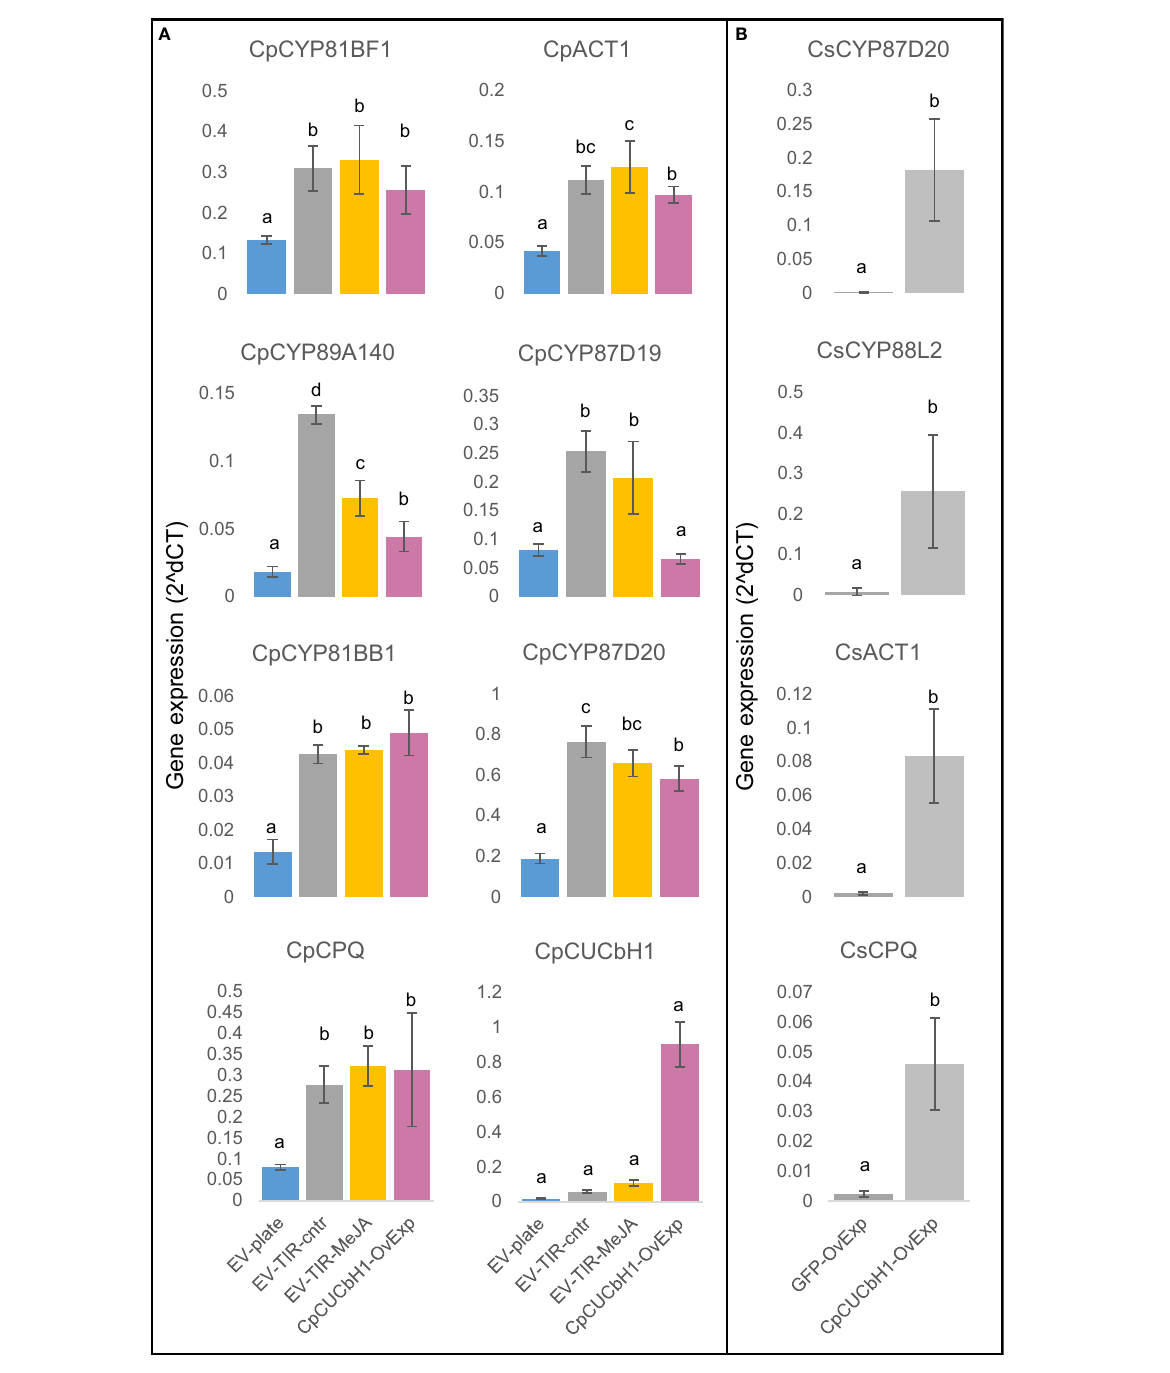
FIGURE 4 Overexpression of C.pCUCbH1 increases expression of cucurbitacin biosynthetic genes in C. pepo hairy roots and C. sativus cotyledons. (A) Relative expression of selected cucurbitacin biosynthetic genes between C. pepo hairy root lines overexpressing C.pCUCbH1 and grown under different conditions: C.pCYP81BF1 (CsCYP81Q58 ortholog C.pCYP89A140 ( C.sCYP89A140 ortholog), C.pCYP81BB1 (CsCYP81Q59 ortholog), C.pCPQ ( C.sCPQ ortholog), C.pACT1 ( C.sACT1 ortholog), C.pCYP87D19 ( C.sCYP87D19 ortholog), C.pCYP87D20 ( C.sCYP87D20 ortholog), C.pCUCbH1 ( C.sBl ortholog). (B) Relative expression for selected cucurbitacin biosynthetic genes between C. sativus cotyledons overexpressing different constructs: C.sCPQ, CsACT1, CsCYP87D20, CsCYP88L2